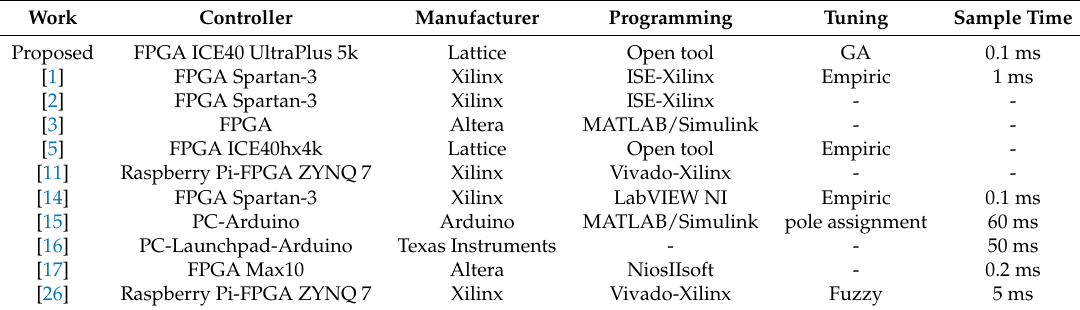
Table 3. Background of open